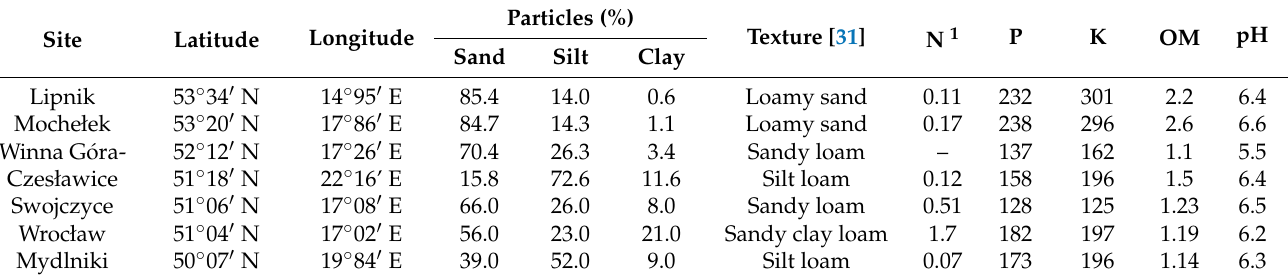
Table 1. Sites of the experiments with their coordinates and soil characteristics.